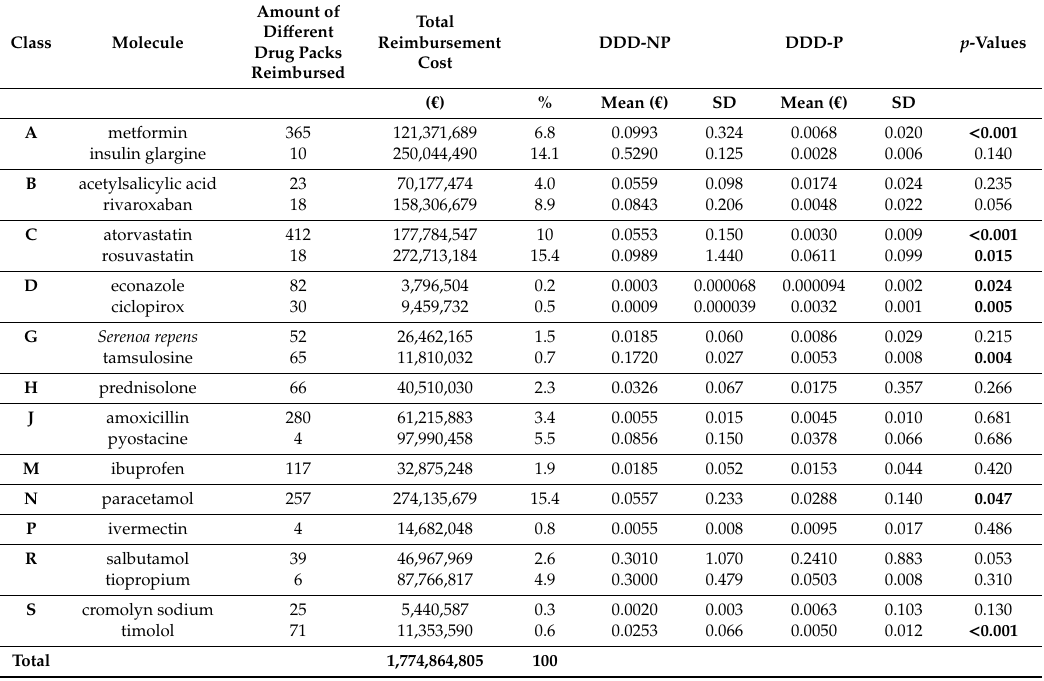
Table 2. Defined Daily Dose (DDD) for each molecule in each Anatomical Therapeutic Chemical (ATC) class in precarious and non-precarious